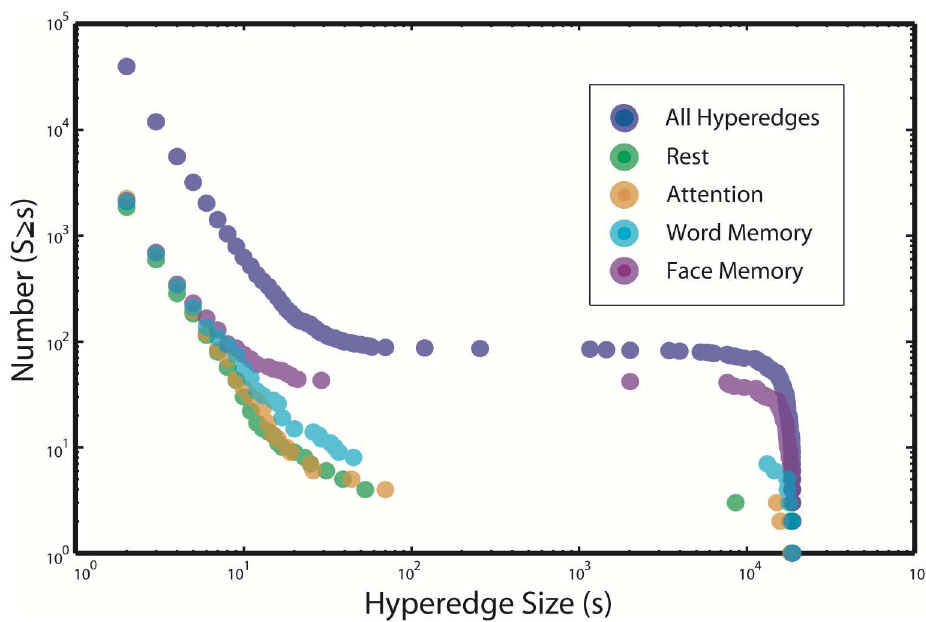
Fig 3. Multi-task cumulative size distribution. The empirical cumulative distribution function of hyperedge sizes for all subjects in the multi-task study. Also shown are traces for the empirical cumulative distribution functions of hyperedge sizes over all subjects for each of the four task-specific hypergraphs. The distributions for both word and face memory tasks tend to have more large hyperedges, while the attention and rest tasks have similar hypergraph cardinalityto the memory tasks over all subjects, but exhibit far fewer large hyperedges.